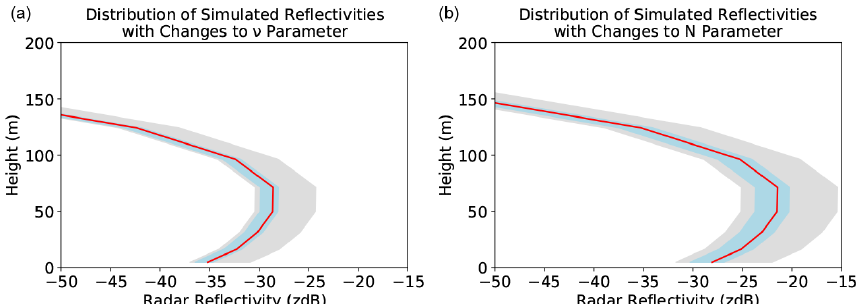
Figure 6. Spread of simulated values of radar reflectivity with height for a change in the microphysical parameters of a modified gamma distribution ν (a) and number concentration (b) for a fog profile. The 25th and 75th percentiles are shown in blue, and the median reflectivity shown by the red